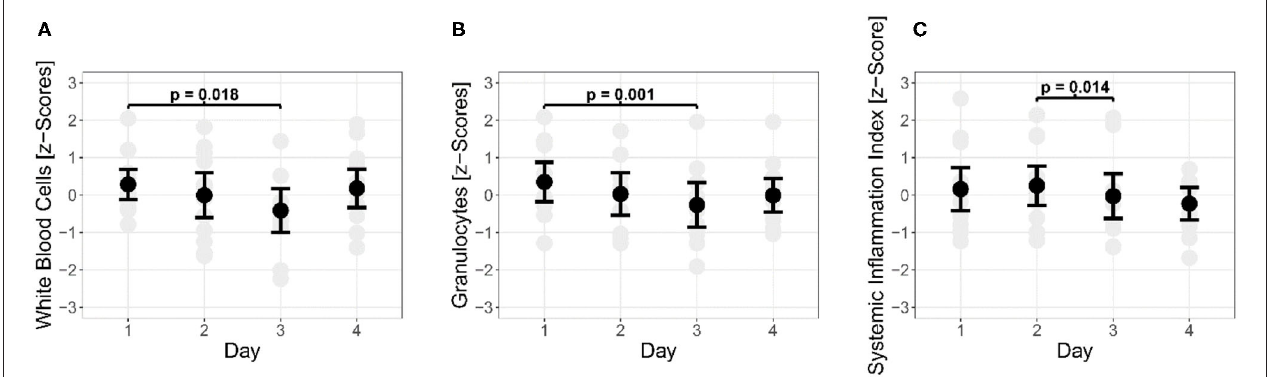
FIGURE 3 | Changes during morning measurements of white blood cells (A) and granulocytes (B) and the Systemic Inflammation Index (C) over a 4-day (three nights) observational period.